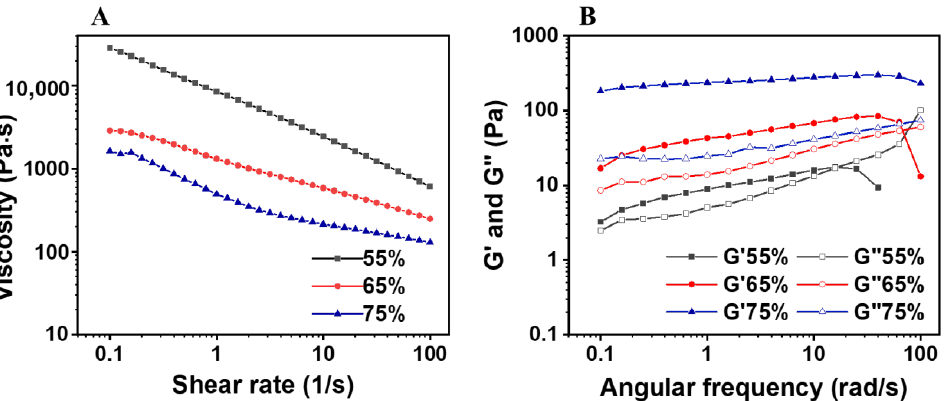
Figure 11. The relationship between viscosity and shear rate for Pickering emulsions with different oil fractions (55%, 65%, and 75%) ( A ). G′ and G″ as a function of frequency for Pickering emulsions with different oil fractions (55%, 65%, and 75%) ( B ).